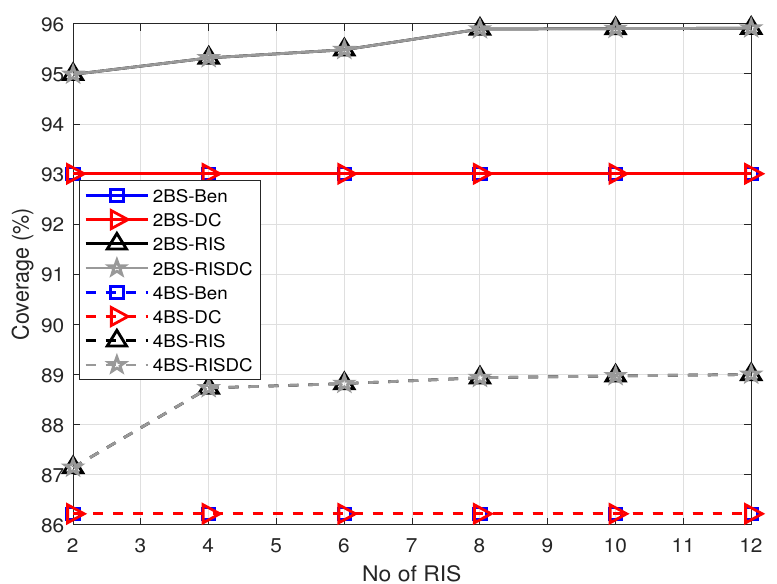
Figure 5. Variation of coverage with respect to number of RISs when ρ bs = [ 2,4 ] , ρ user = 60, α = 1, and µ b = 10.